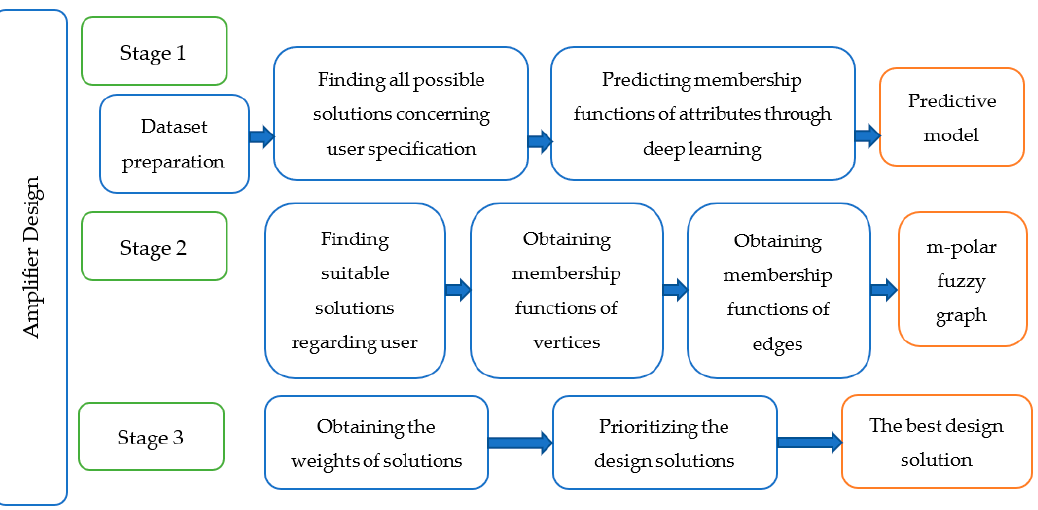
Figure 1. Proposed method.